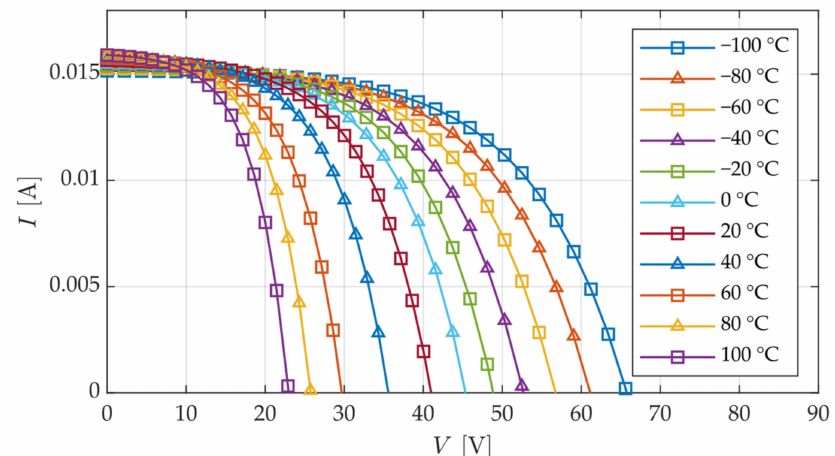
Figure 11. I-V characteristic of sample Al 6 at different temperatures in the fourth quadrant; measure- ment with Keithley 2450 SMU’s sweep function under Class BCA Solar Simulator with irradiance 908.2 W/m 2 in wavelength range 200 nm to 1100 nm.